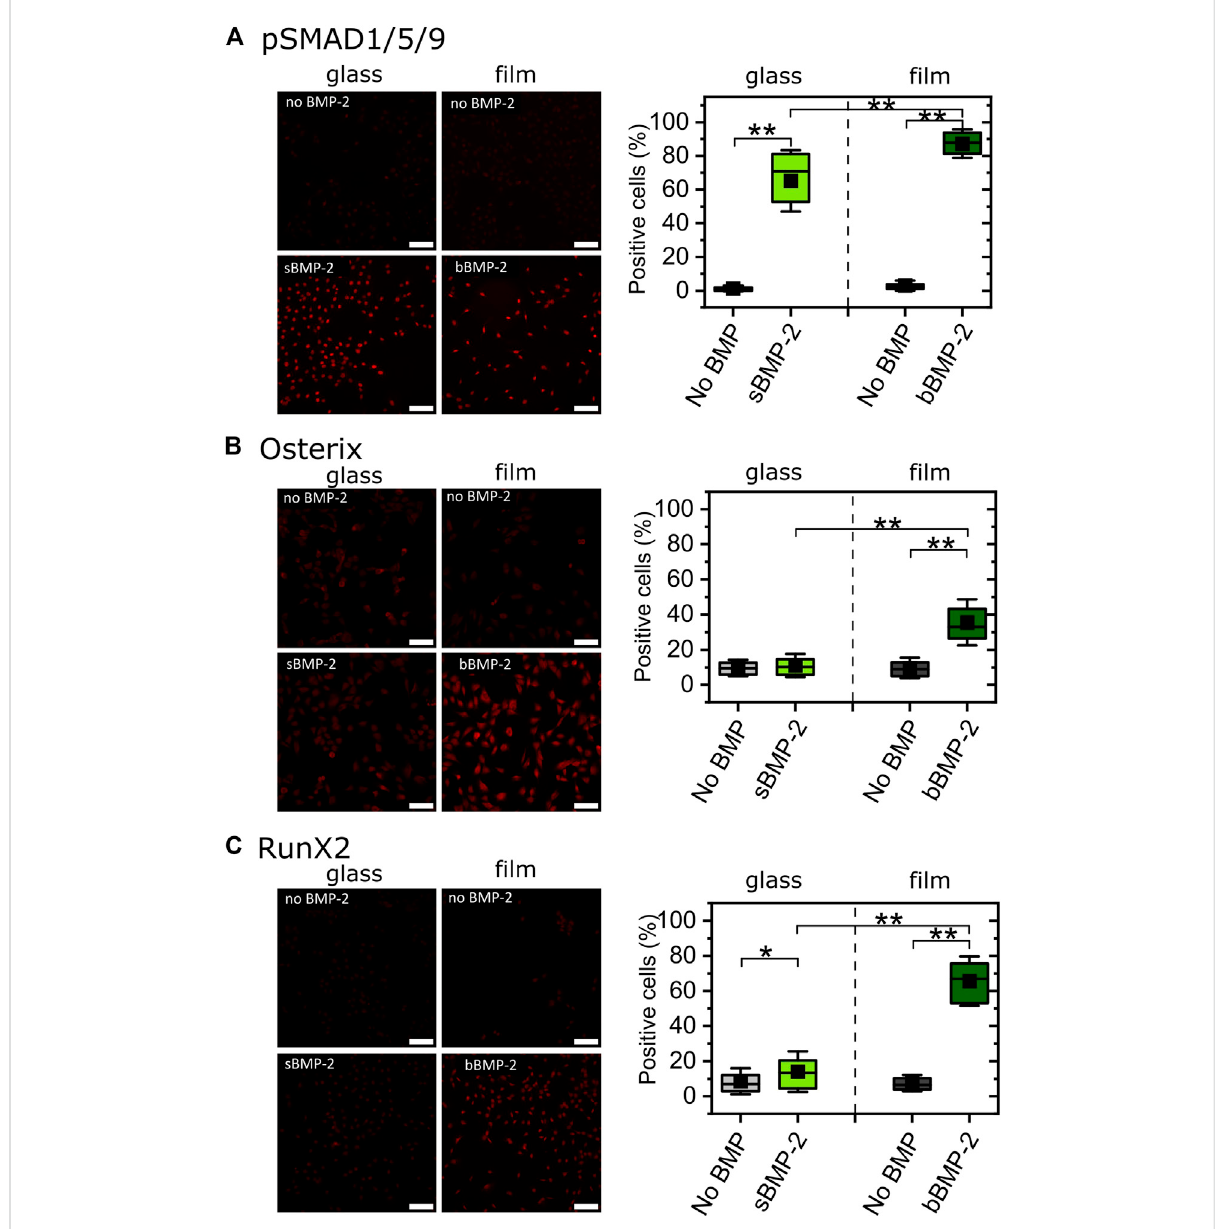
FIGURE 5 Quanti fi cation of the nuclear localization of selected transcription factors in response to soluble and matrix-bound BMP-2. Selected transcription factors that are representative of bone differentiation, i.e., (A) pSMAD1/5/9, (B) osterix, and (C) RunX2, were quanti fi ed for C2C12 myoblasts grown on glass in the presence or absence of sBMP-2 and for cells cultured on biomimetic fi lms with or without matrix-bound BMP-2. Representative immuno- fl uorescence images of cells cultured inthe differentconditions are shown. Scale bar of fl uorescent images is 100 µm.Thecorrespondingquanti fi cationsofthenuclearlocationofthetranscriptionfactorsbasedontheimmuno- fl uorescencearegivenforcells inthepresenceofsBMP-2,bBMP-2andintheabsenceofBMP-2.The%ofpositivecellsisgivenforeachcondition.Dataarerepresentedasboxplots for three independent